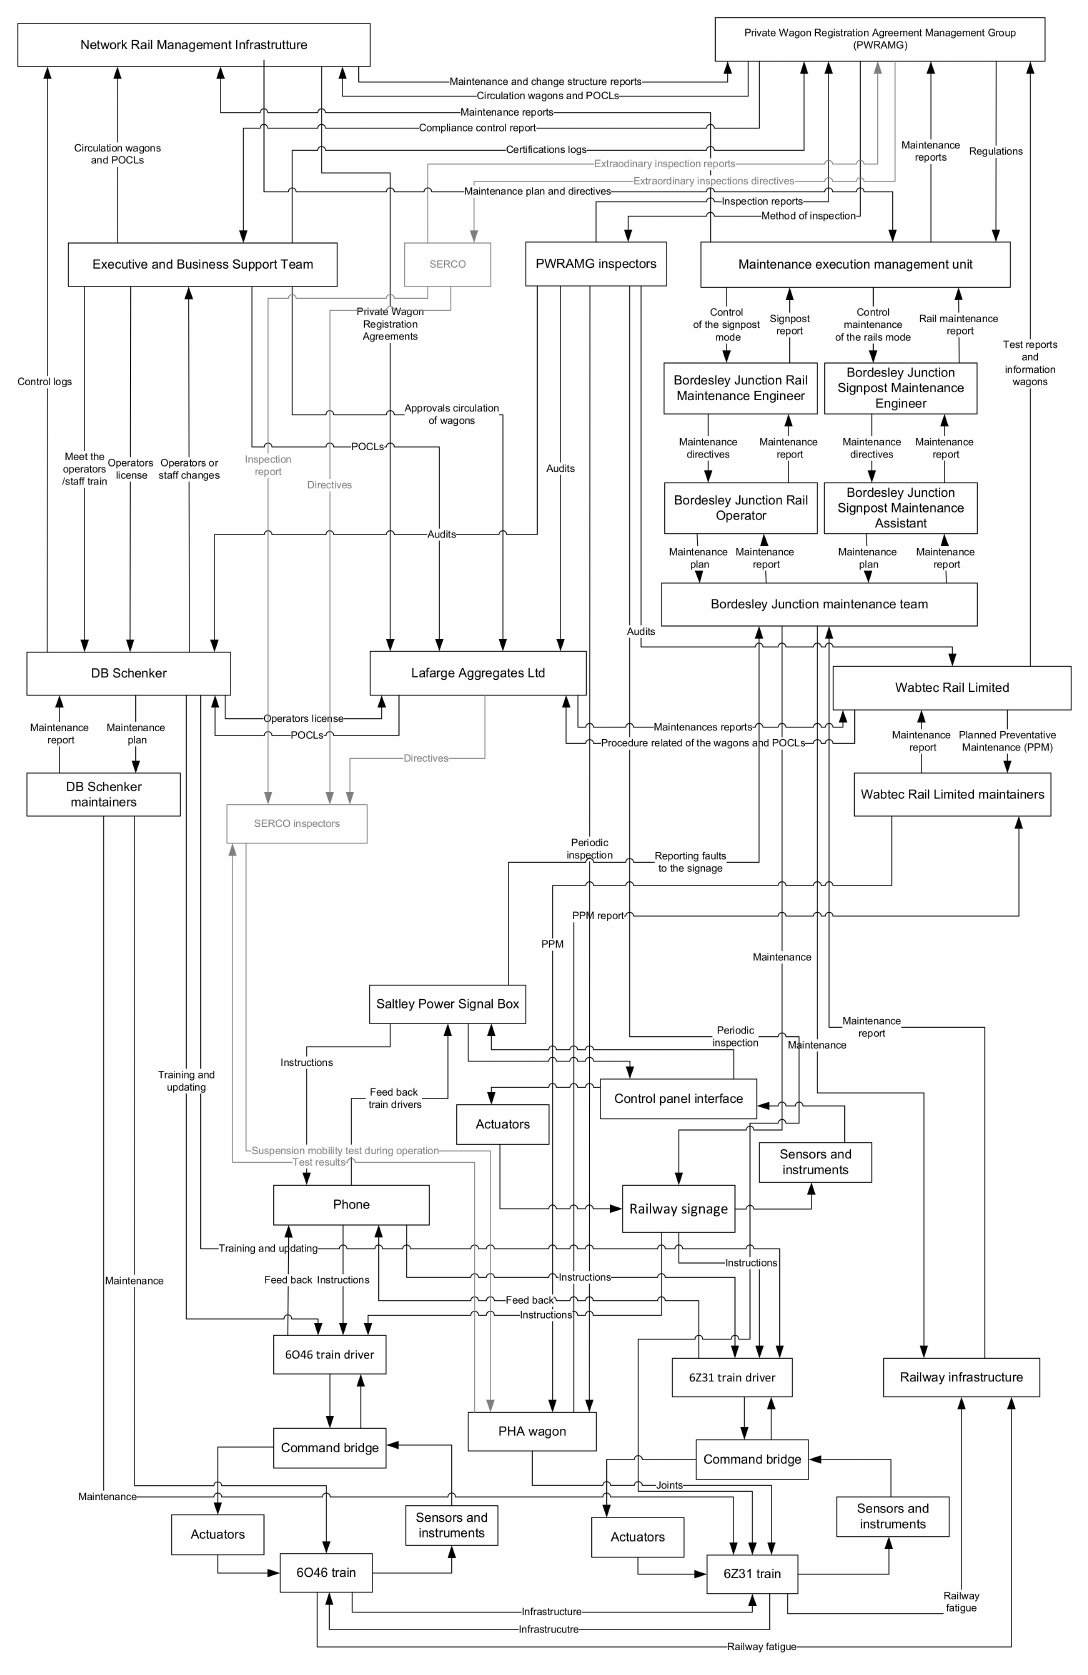
Figure 5. Detailed SCS model of the event under